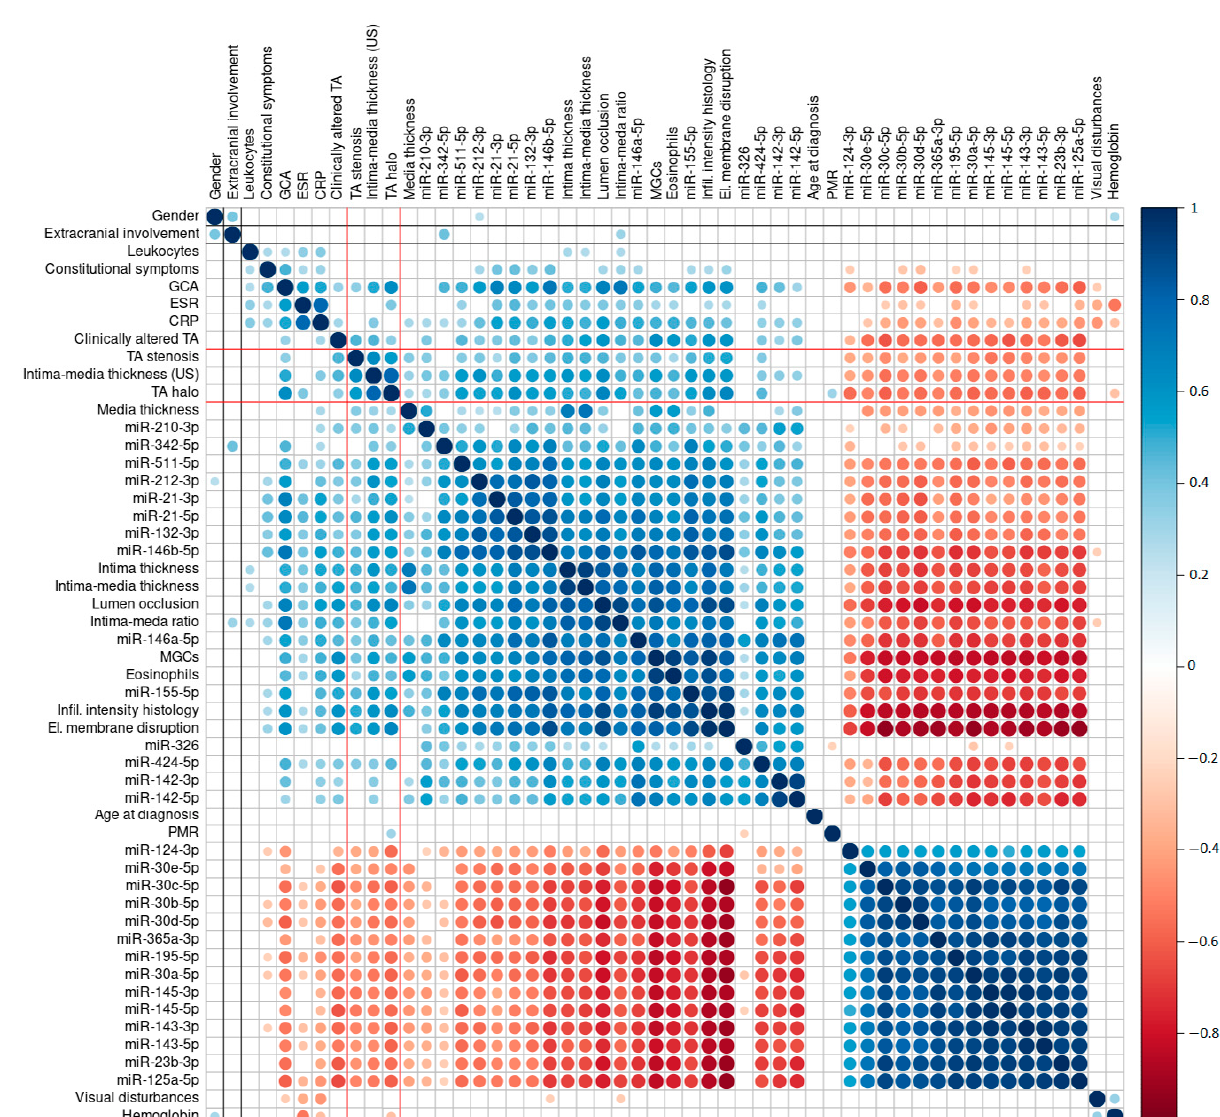
Figure 3. Correlation matrix of hierarchically clustered associations between all diagnostic parameters included in the study. Associations were calculated based on variable type combinations (nominal vs. nominal— ϕ ; nominal vs. numeric— r ; numeric vs. numeric— ρ ). Blank squares represent non- significant associations. The direction and level of corresponding correlation coefficients are presented with colors (blue for positive correlation; red for negative correlation) and their respective intensities with circle size (size of the circle increases proportionally to the correlation intensity). Associations with US examination parameters are highlighted with black (extracranial involvement) and red (luminal stenosis, US-measured intima–media thickness, halo sign, and GCA diagnosis based on US examination)